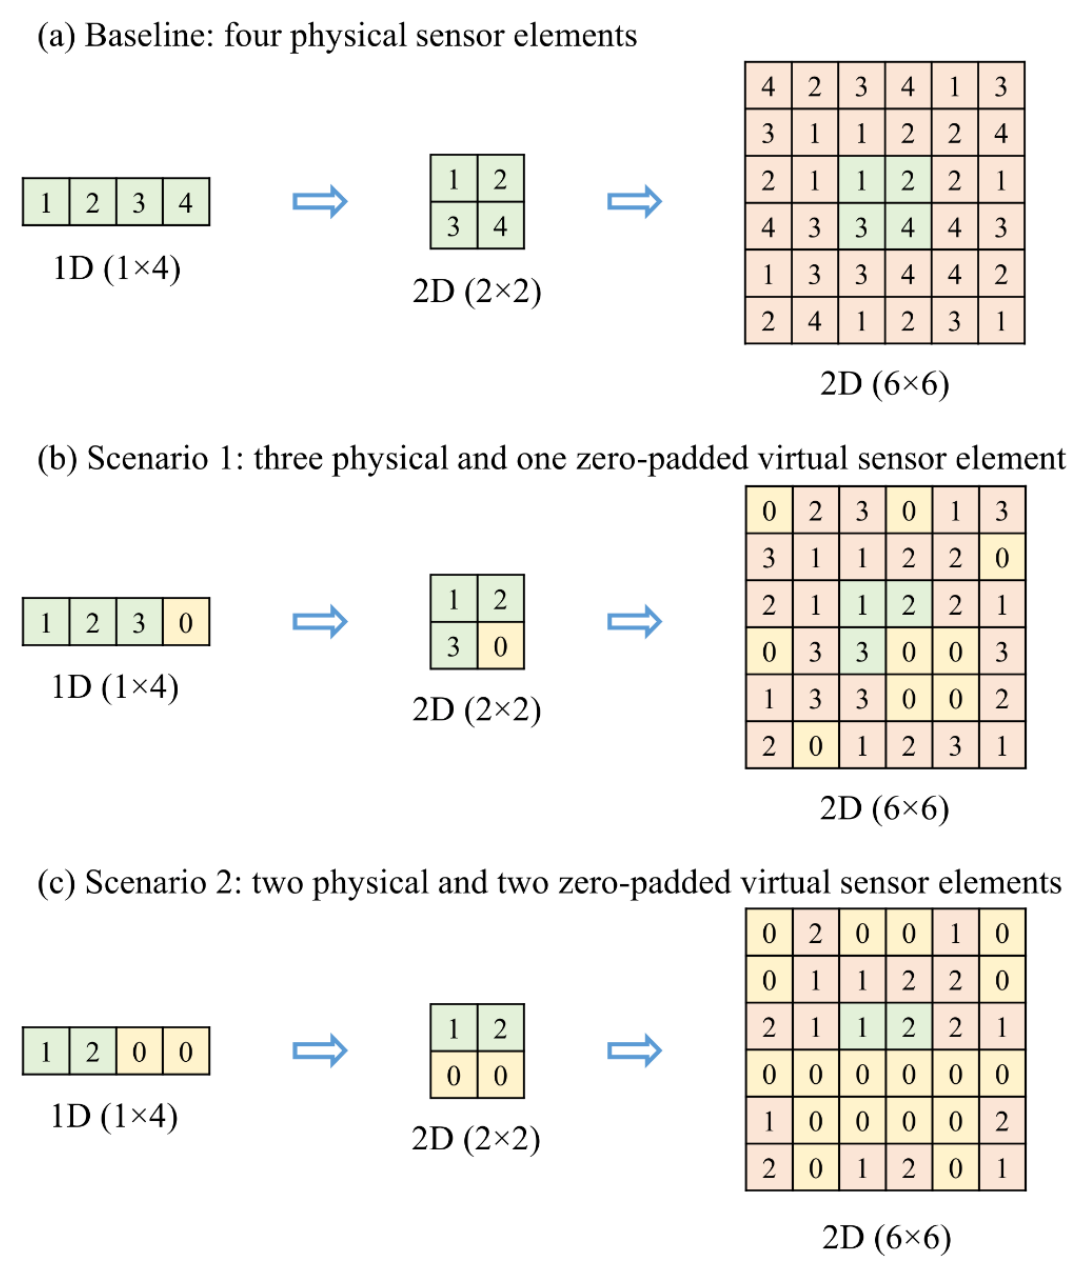
Figure 4. Sensor data vector augmentation procedure for; unoptimized gas sensor array ( a ); Scenario 1 when one redundant sensor element has been removed ( b ); Scenario 2 when two redundant sensor elements have been removed ( c ).